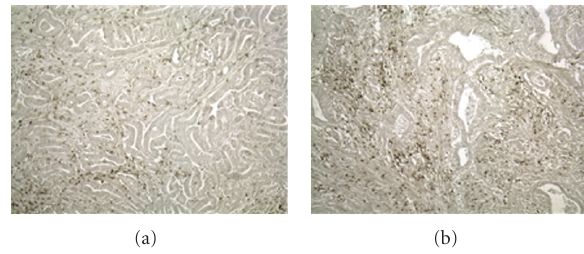
Figure 1: Tumors from Lynch Syndrome patients experience in- creased infiltration of tumors with CD3+ lymphocytes (b) com- pared to non-Lynch Syndrome patients